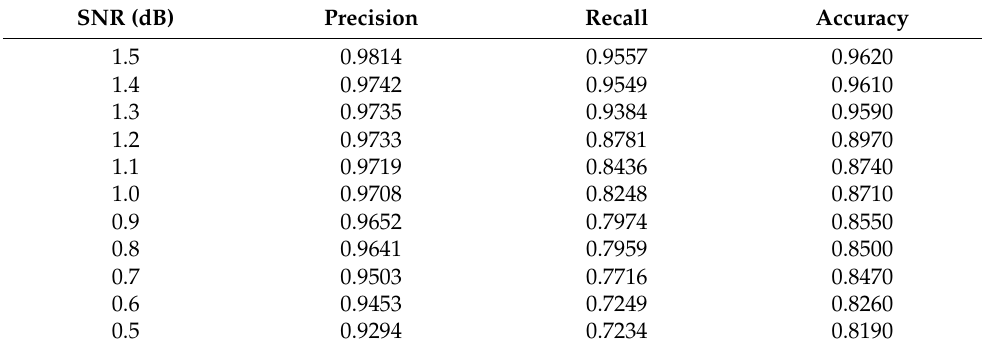
Table 5. Running time at 1.2–3 dB.